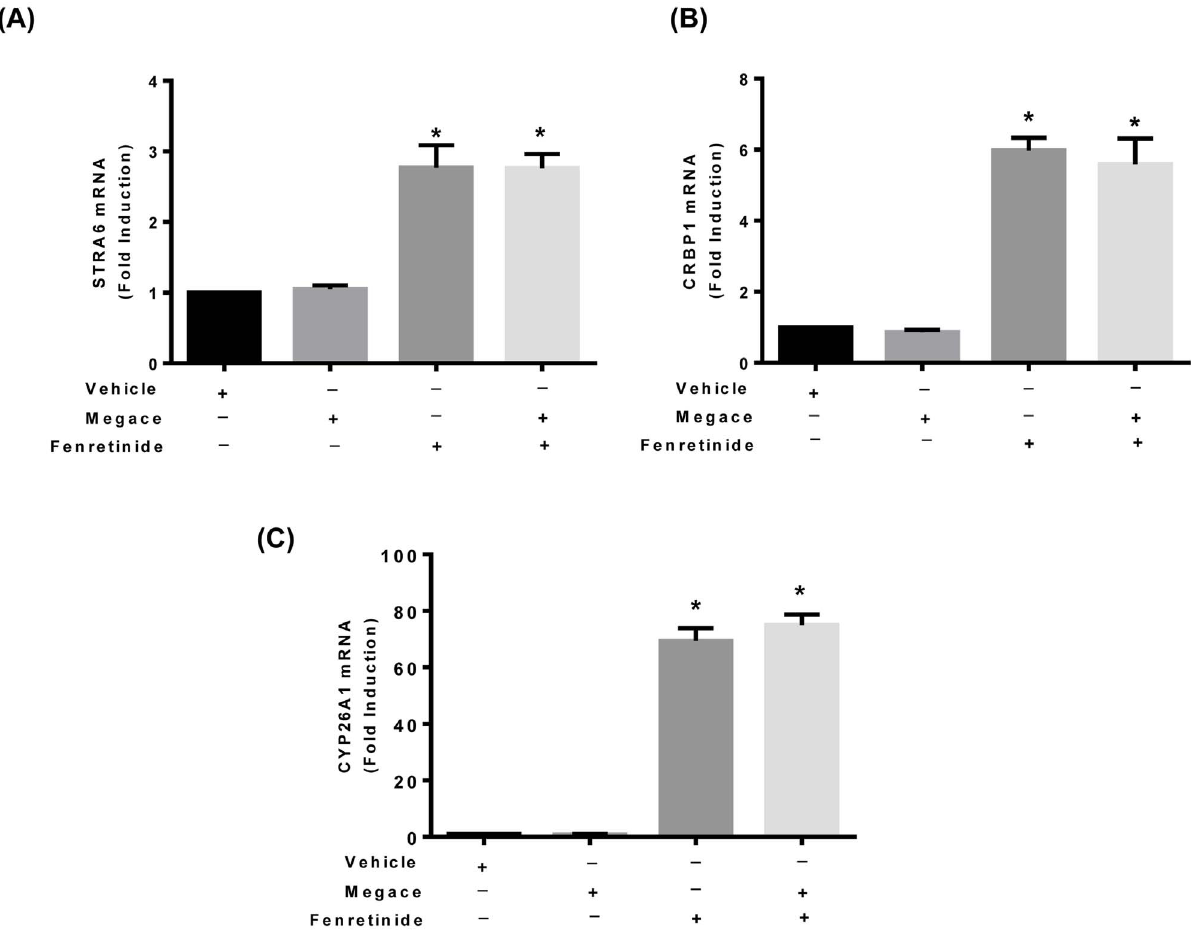
Figure 3. Effects of megace on retinol uptake genes in endometrial cancer Ishikawa cells (A–C). Total RNA was isolated from Ishikawa cells treated with DMSO (Vehicle), megace, fenretinide and a combination of megace and fenretinide both. Relative mRNA expressions of ( A ) STRA6, ( B ) CRBP1 and ( C ) CYP26A1 were analyzed with RT- qPCR. Data are presented as fold change in relative expressions of mRNA from DMSO treated samples and represent the mean 6 SEM of 5 independent experiments. An asterisk indicates a significant (* P , 0.05) increase in mRNA expression of these genes in Ishikawa cells treated with fenretinide or megace + fenretinide cells as compared to DMSO treated cells.